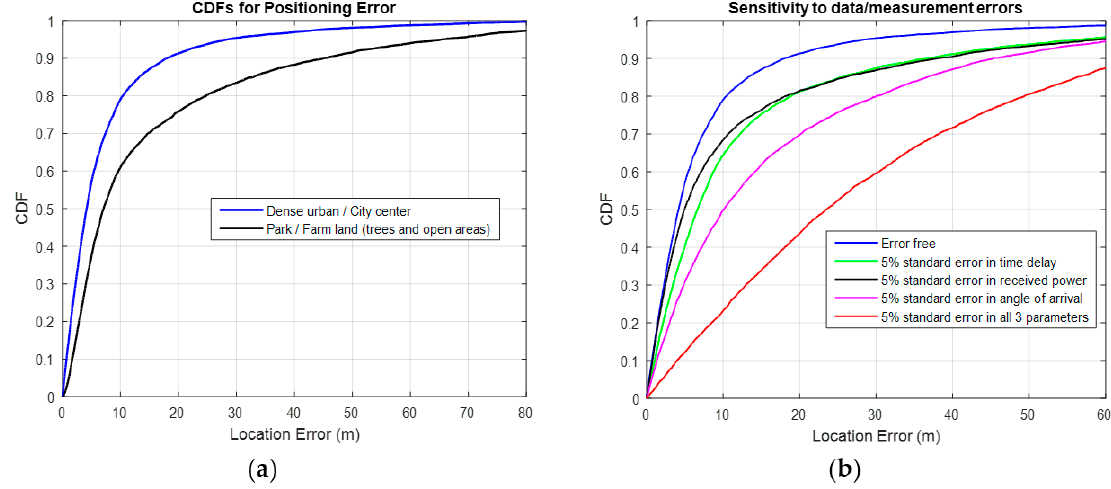
Figure 7. ( a ) Localisation performance for the two environments. ( b ) Sensitivity to measurement